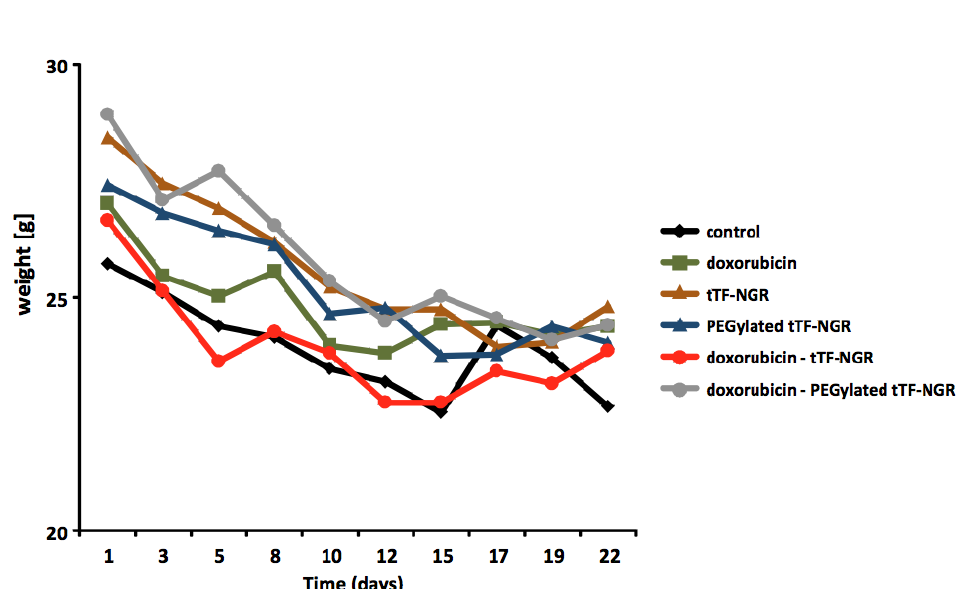
Figure 1. Body weight curves of athymic mice during combination experiments with tTF-NGR. Body weight curves of athymic mice during combination experiments with tTF-NGR (1 mg / kg b.w. × 2), PEGylated tTF-NGR (5 mg / kg b.w. × 2), and the combination of these compounds with doxorubicin (5 mg / kg b.w.). One representative experiment of multiple from Reference 15 is depicted.